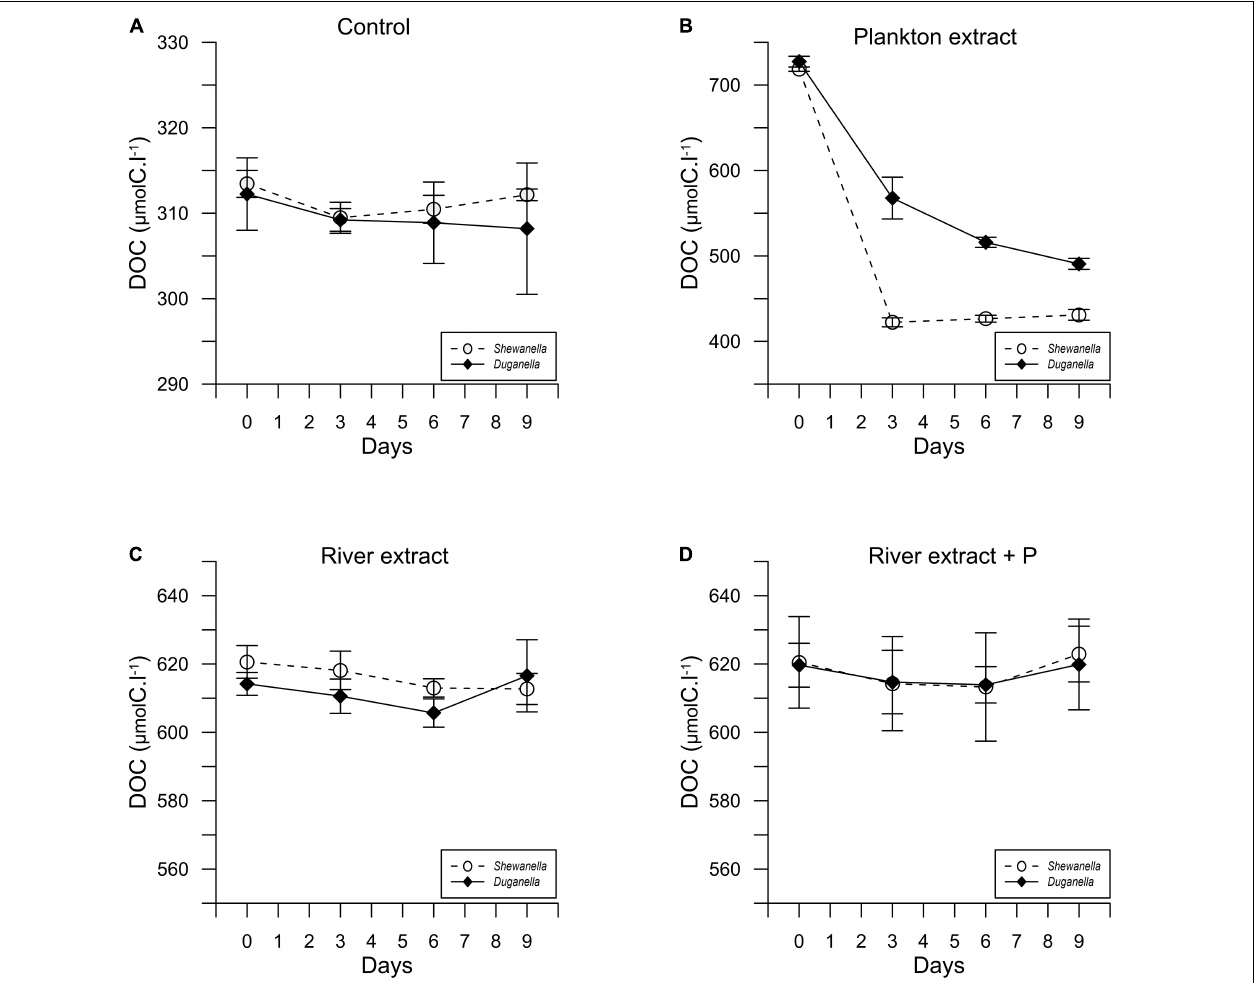
FIGURE 2 | Temporal variation of the DOC concentration in Shewanella and Duganella incubations: (A) control, (B) plankton extract, (C) river extract, and (D) river extract + P. Data points show average values, and error bars denote standard